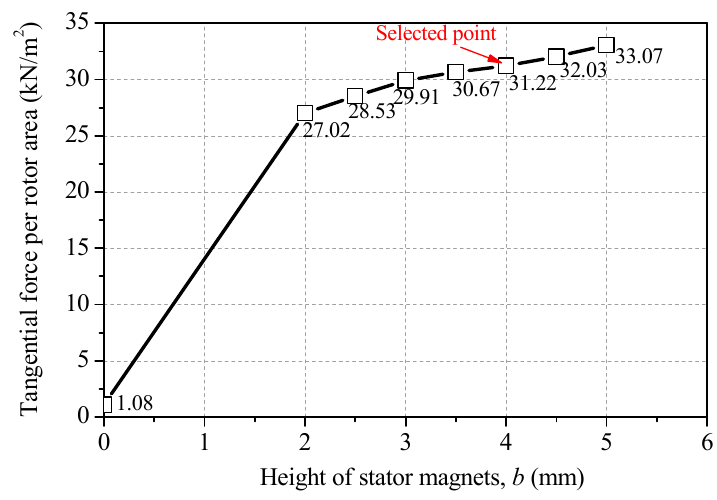
Figure 7. Tangential force density versus the height b of the stator magnets.